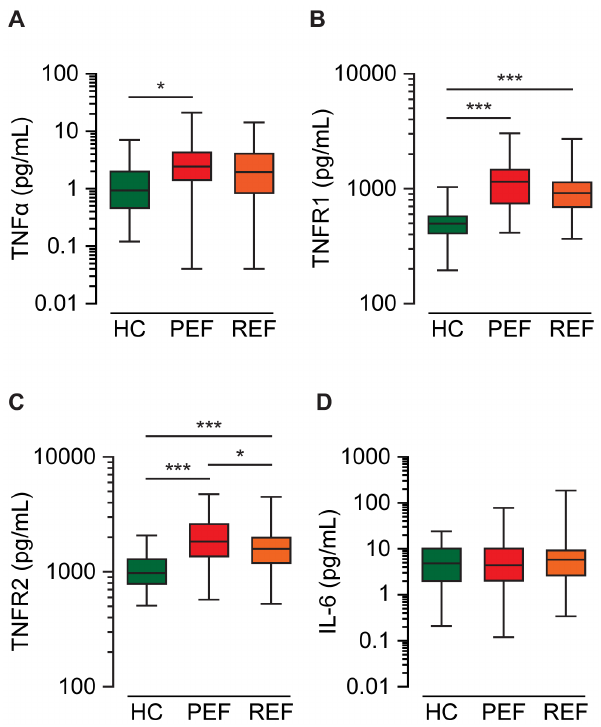
Figure 1. Circulating inflammatory markers in healthy control (HC), HFPEF (PEF) and HFREF (REF). Box and whisker plots show the relative distributions of TNF- a (A), TNFR1 (B), TNFR2 (C) and IL-6 (D) levels. * P , 0.05, *** P , 0.001 for Kruskal-Wallis Test with pairwise comparisons.